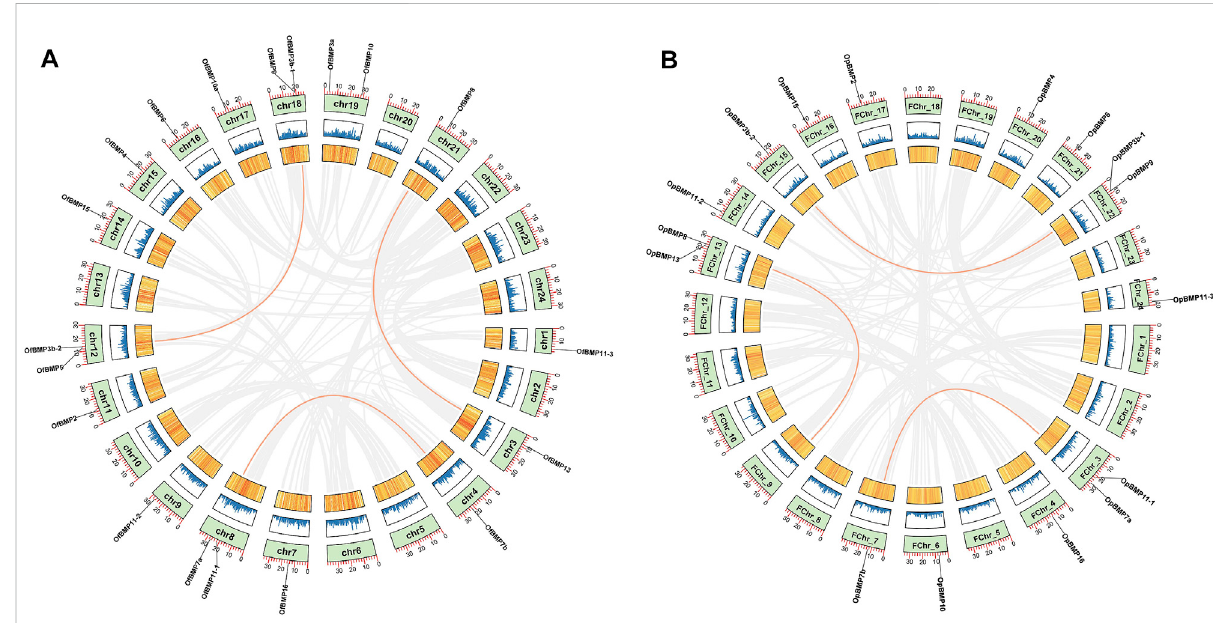
FIGURE 5 Chromosome localization and collinearity analysis of BMP genes in O. fasciatus and O. punctatus . (A) Represents O. fasciatus ; (B) represents O. punctatus